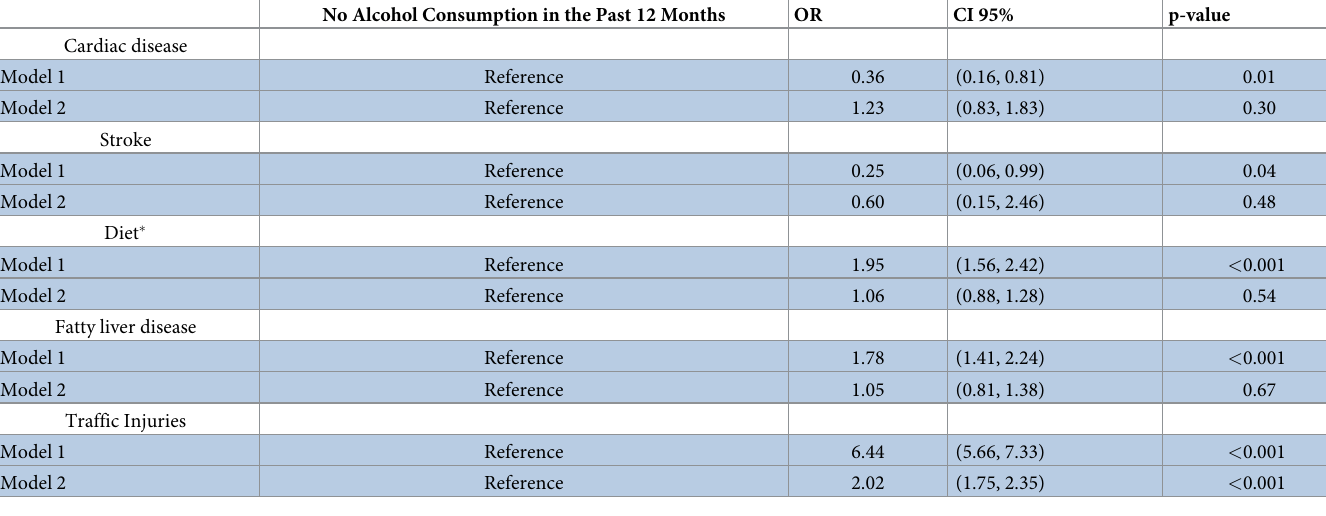
Table 3. Association of alcohol related disorders with alcohol consumption in logistic regression models: Results from the National Surveillance of Non-Communi- cable Diseases Survey (STEPs).